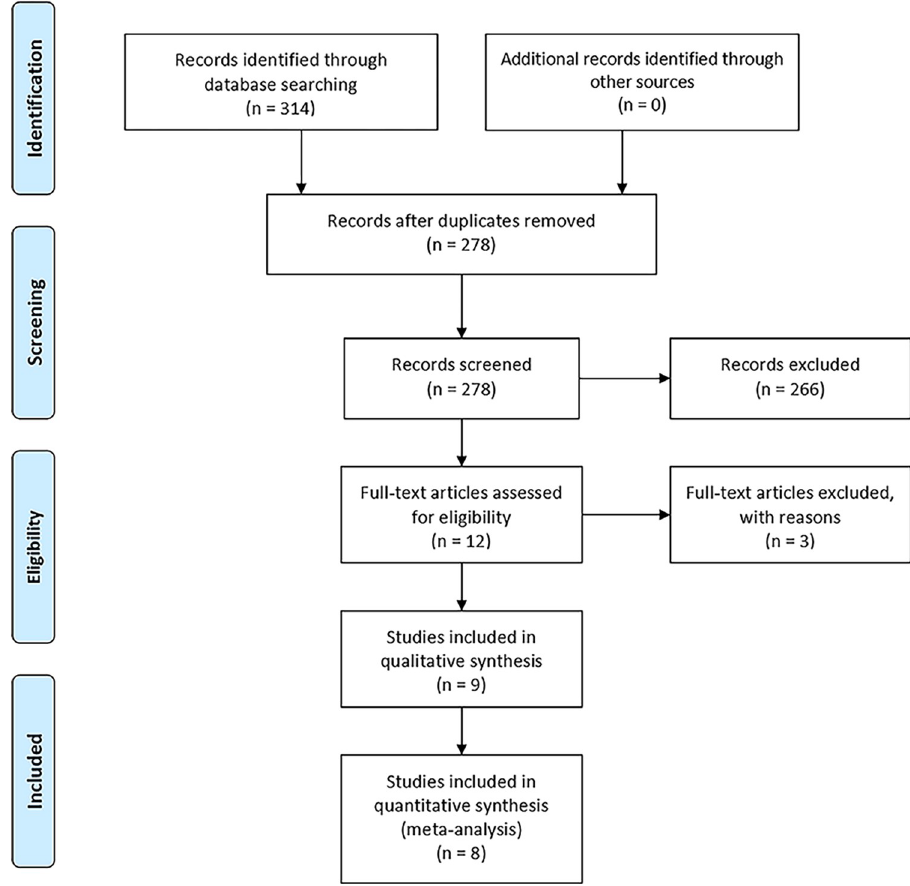
Fig 1. Flow diagram of study screening and